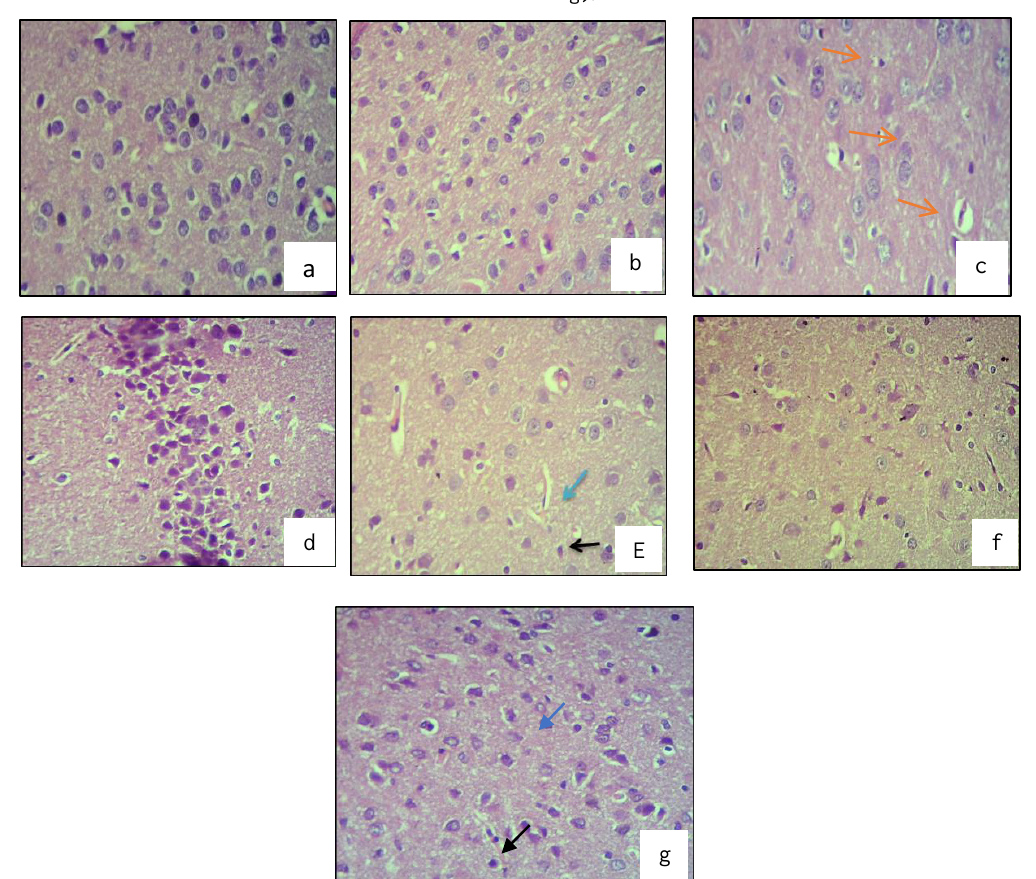
Figure 1. Histopathological section of brain in various experimental rats' groups; (haematoxyline and eosin; X40). a: group I (negative control (corn oil);b: group II (vit E 100mg/kg);c: group III (Q10 50 mg/kg);d: group IV (positive control (Dox 2.5 mg/kg);e: group V (vit E100mg/kg prior to a IP dose of Dox 2.5 mg/kg ;f: group VI (Q10 50mg/kg prior to IP dose of Dox 2.5 mg/kg);g: group VII(vit E 100mg/kg, and Q10 50mg/kg prior to IP dose of DOX 2.5mg/kg)Negative control group, group II, and group III showed normal brain section. Positive control group characterized by shows marked neuronal degeneration with frequent nuclear pyknosis , and Irregular darkly stained cells with pyknotic nuclei and surrounded with halos arrows were prominent( red arrow) The lesion in groups V,VI,VII revealed mild Congestion of blood vessels ( black arrow) with some appear with darkly stained nucleus surrounded with halo( blue